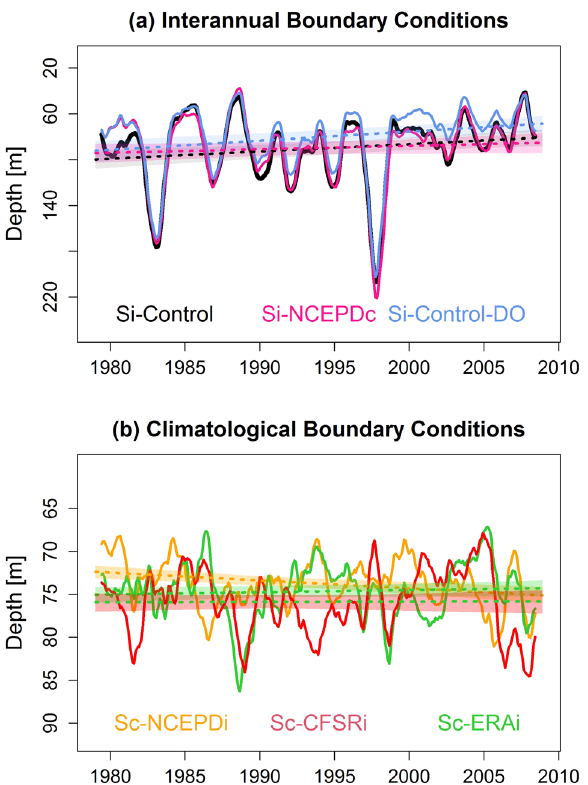
Figure 3. Oxycline response to remote and local forcing. Temporal evolution of modeled oxycline depth for the model experiments described in Table 1. Model simulations are either forced by interannual boundary conditions (Si-Control (black line), Si-NCEPDc (cyan line), Si-Control-DO (blue line), or by climatological boundary conditions and interannual wind forcing (Sc-NCEPDi (yellow line), Sc-CFSRi (red line), Sc-ERAi (green, line). Note the change of scale in the vertical axis in ( a ) and ( b ) marking the weaker trends in ( b ). The figures were generated using the software R (R Core Team, version 4.1.1., http:// www.R- proje ct. org/).